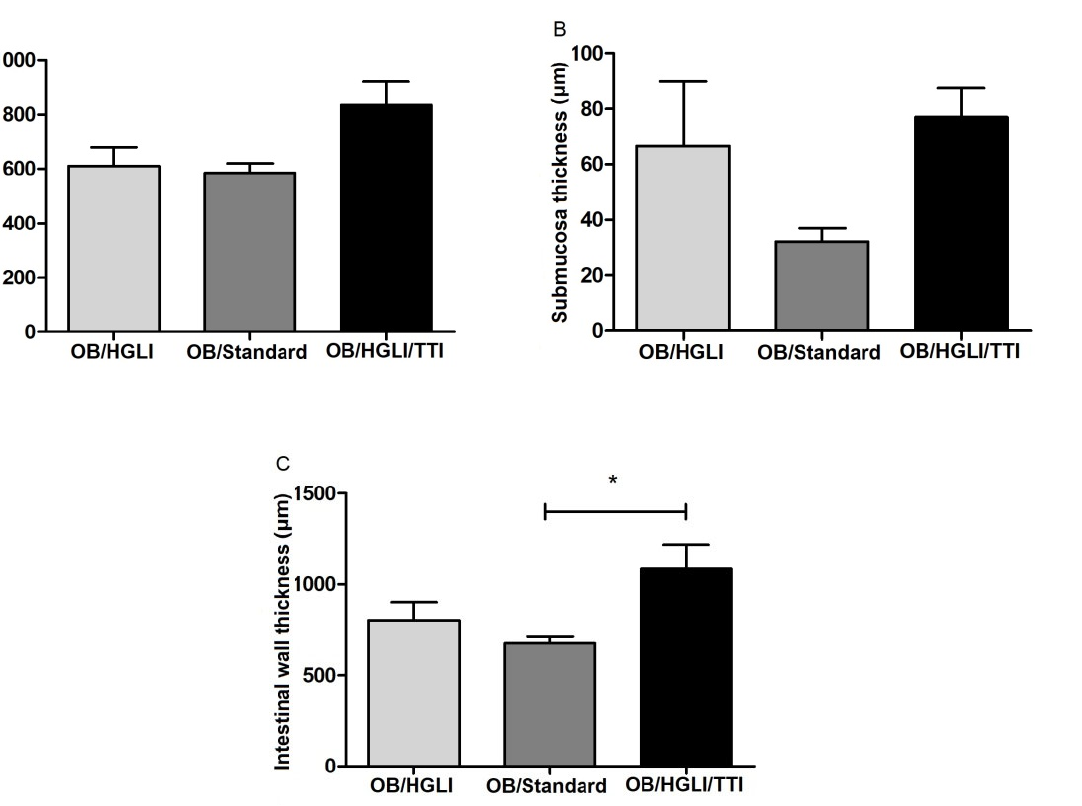
Figure 12. Histomorphometric analysis of intestinal parameters evaluated in Wistar rats with obesity induced by HGLI diet, after ten days of experiment. ( A ) Mucosa thickness, ( B ) submucosa thickness, and ( C ) intestinal wall thickness. OB/HGLI: group without treatment, OB/Standard: group treated with a nutritionally adequate diet (standard diet Labina ® ), and OB/HGLI/TTI: group treated with the trypsin inhibitor isolated from tamarind seeds (TTI). * p < 0.05 (one-way ANOVA test with